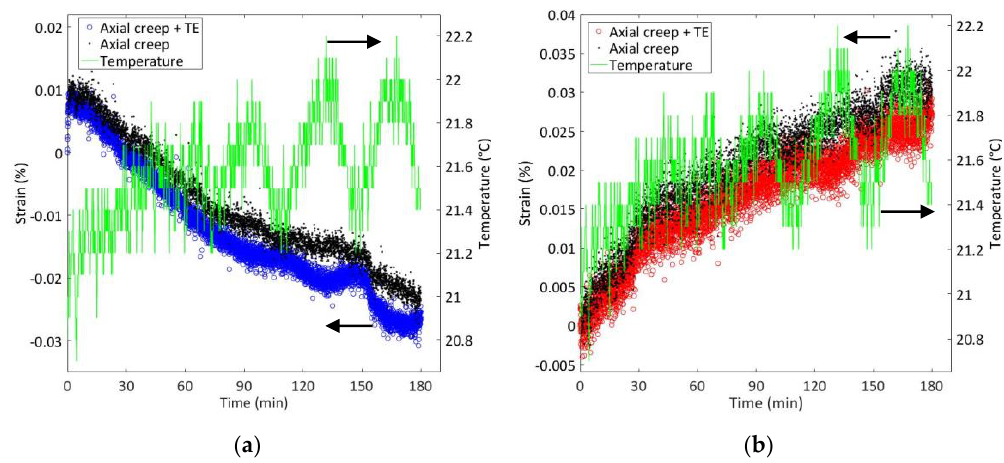
Figure 7. ( a ) Axial and ( b ) lateral creep deformations of LSCF-P20 sample for 3 h under 50-MPa maximum stress superimposed with temperature measurement during the experiment.